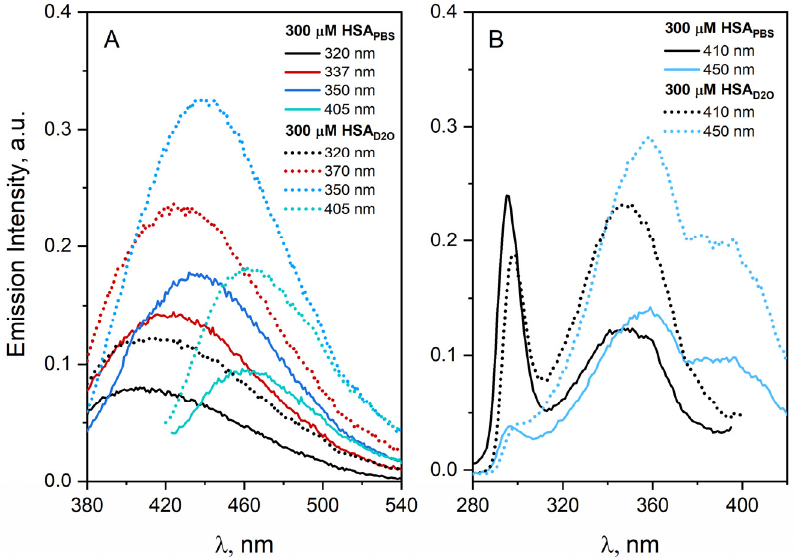
Figure 6. ( A ) Emission spectra of the neat HSA solution (300 µM) and HSA solution (300 µM) containing D 2 O. The excitation wavelengths are given in the figure. ( B ) Emission excitation spectra of the neat HSA solution (300 µM) and HSA solution (300 µM) containing D 2 O. The emission wavelengths are given in the figure.